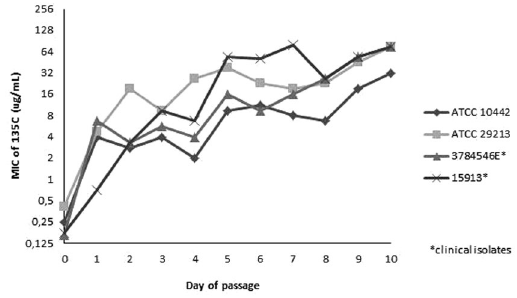
Figure 3. Serial passage of S. aureus strains with 135C showing MICs over time. Data points are the geometric mean of two independent experiments repeats, each conducted in duplicate (4 values per day per isolate).